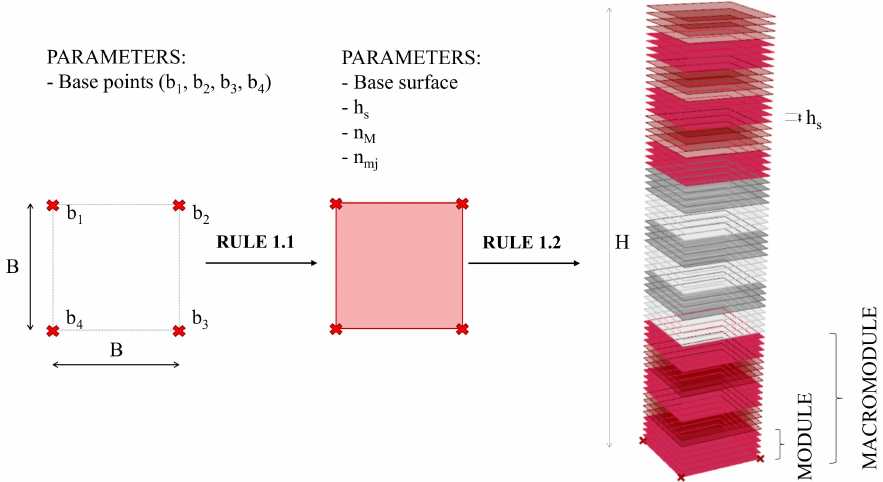
Figure 2. Rules for the definition of the design